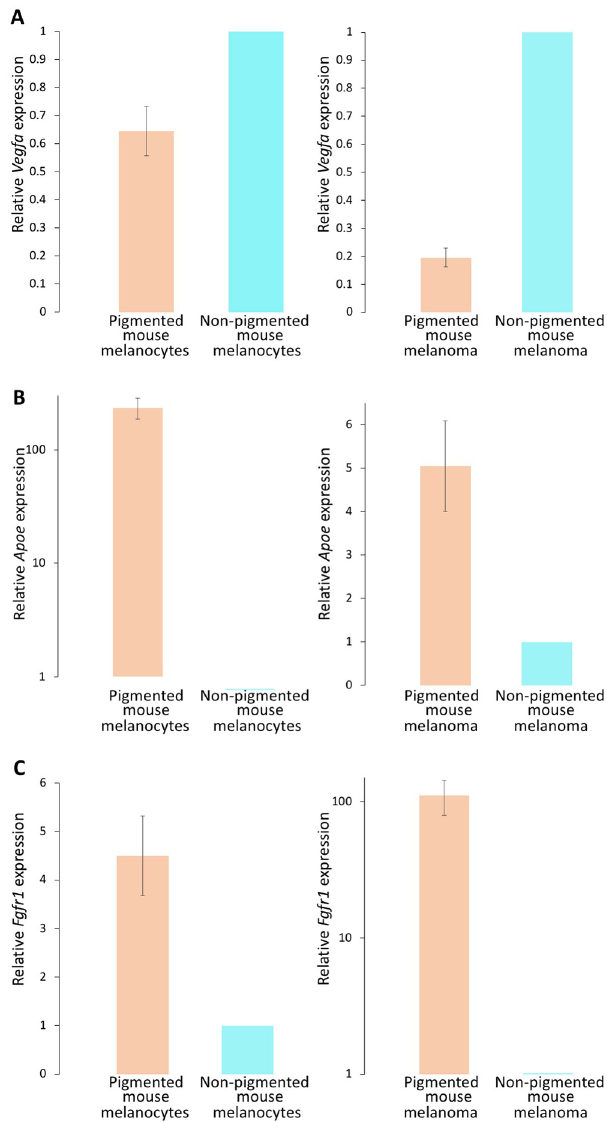
Fig 7. MC1R-dependent expression of Vegfa , Apoe , and Fgfr1 . Two isogenic cellular systems of MC1R loss-of- function were used to define relationships between pigmentation and the expression of (A) Vegfa , (B) Apoe , and (C) Fgfr1 . Consistent with findings in Black and White individuals shown in Fig 6, Vegfa was found to be down-regulated in pigmented, as compared to non-pigmented cells, while Apoe and Fgfr1 were both up-regulated in pigmented versus non-pigmented